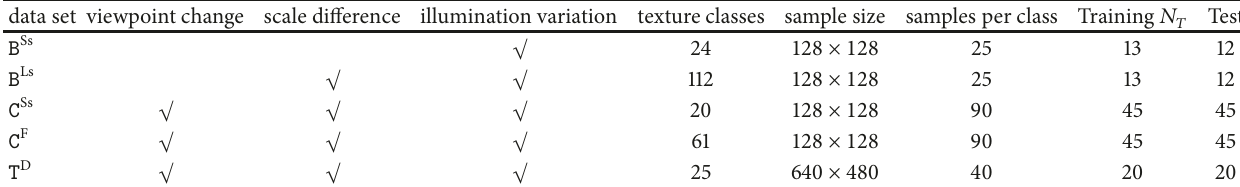
Table 1: Summary of the data sets used in the experiments.